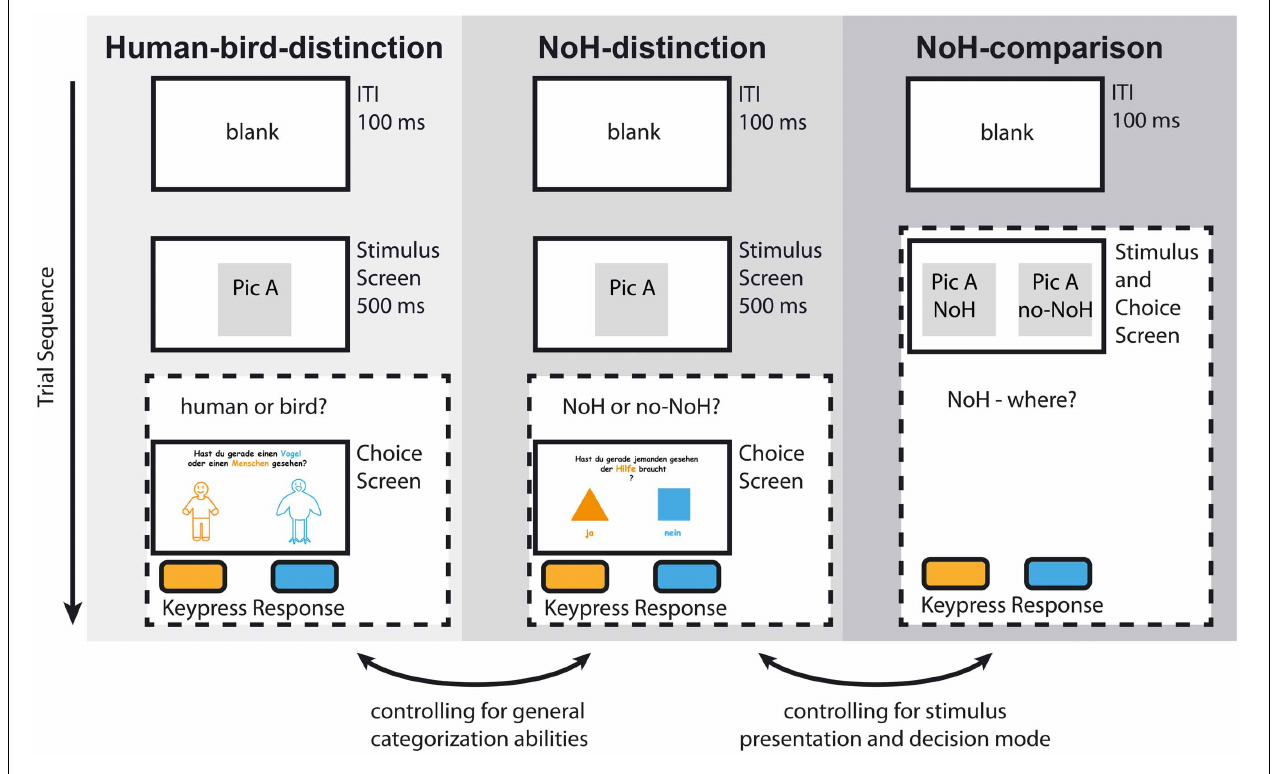
FIGURE 2 | Experimental paradigms. The sequence for one example trial is illustrated for Human-bird-distinction (light gray), NoH-distinction (medium gray), and NoH-comparison (dark gray). Dashed frames indicate presentation without predefined time-restriction. Note that Human-bird-distinction and NoH-distinction had identical time restricted stimulus presentations (500ms), randomization routines and experimental designs (2AFC); decision and